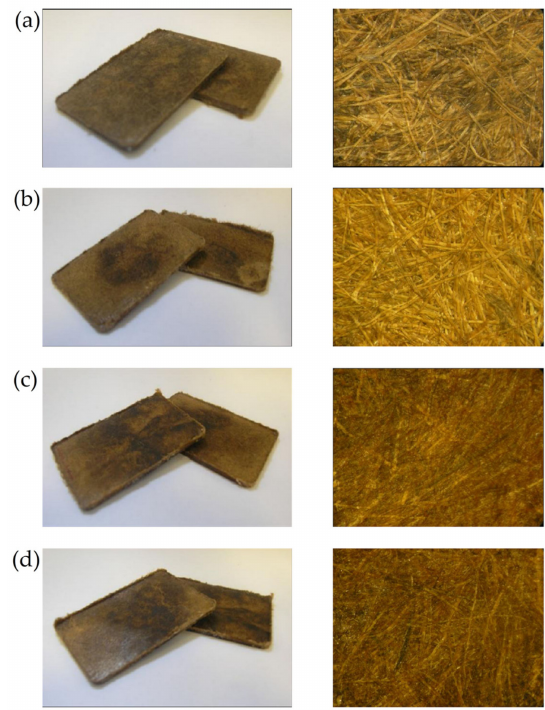
Figure 2. Optical images of the fibreboards ( left ) and the surface appearance ( right ) with PO fibres subjected to different chemical treatments, ( a ) untreated; ( b ) NaOH; ( c ) NaOH + APTMS and ( d ) NaOH +